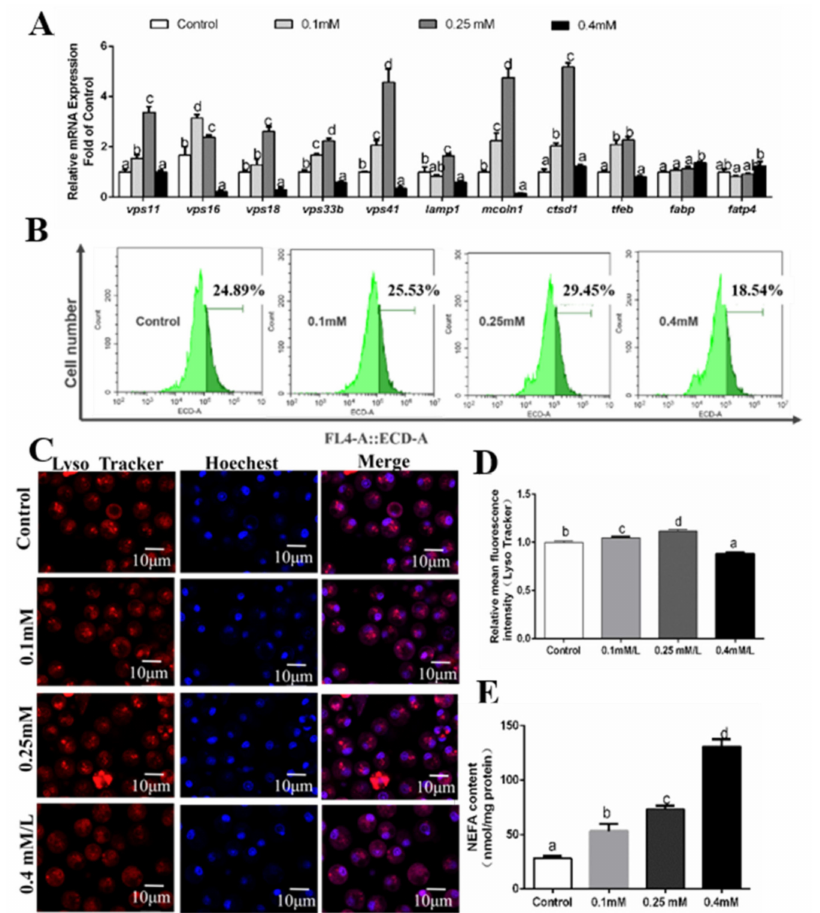
Figure 8. E ff ects of 48 h OA incubation on autophagosomes in hepatocytes of P. fulvidraco. ( A ) The e ff ect of 48 h OA incubation on the mRNA levels of autolysosome-related genes; data (mean ± SEM, n = 3) were expressed relative to expression of housekeeping genes ( b2m and gapdh (M = 0.1550)). ( B ) The e ff ect of 48 h OA incubation on intracelluar autolysosomes demonstrated by flow cytometry analysis of the presence of Lyso Tracker-stained intracellular autolysosomes. ( C ) Representative confocal microscopy image of hepatocytes co-stained with Hoechest (blue) and Lyso Tracker (red) after 48 h OA incubation. ( D ) The e ff ect of 48 h OA incubation on intracelluar autolysosomes demonstrated by flow cytometric analysis of red (FL4) mean fluorescence intensity. ( E ) E ff ects of 48 h OA incubation on NEFA content. Letters ( a–d ) denote significance, P <